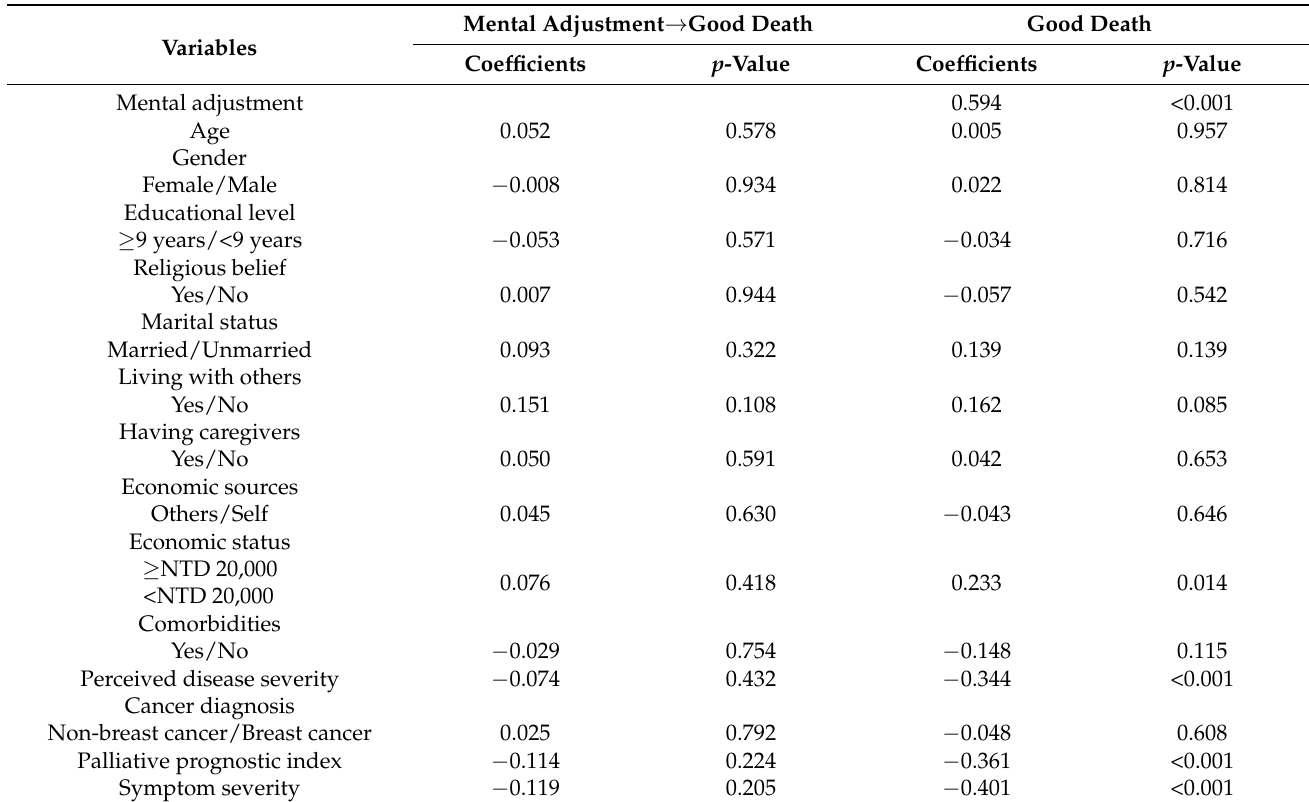
Table 4. Path modeling for mental adjustment and comprehensive quality of life outcome (CoQoLO) among terminally ill cancer patients (N =